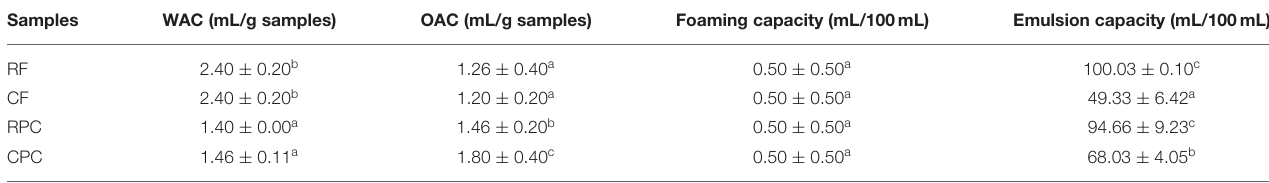
TABLE 2 | Physicochemical properties of tepary bean flours (RF and CF) and protein concentrates (RPC and CPC). Samples